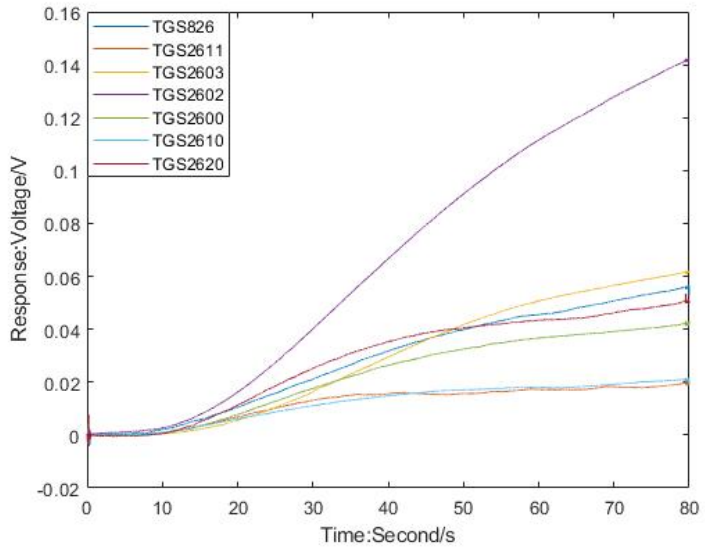
Figure 2. The response curve of electronic nose sensors.